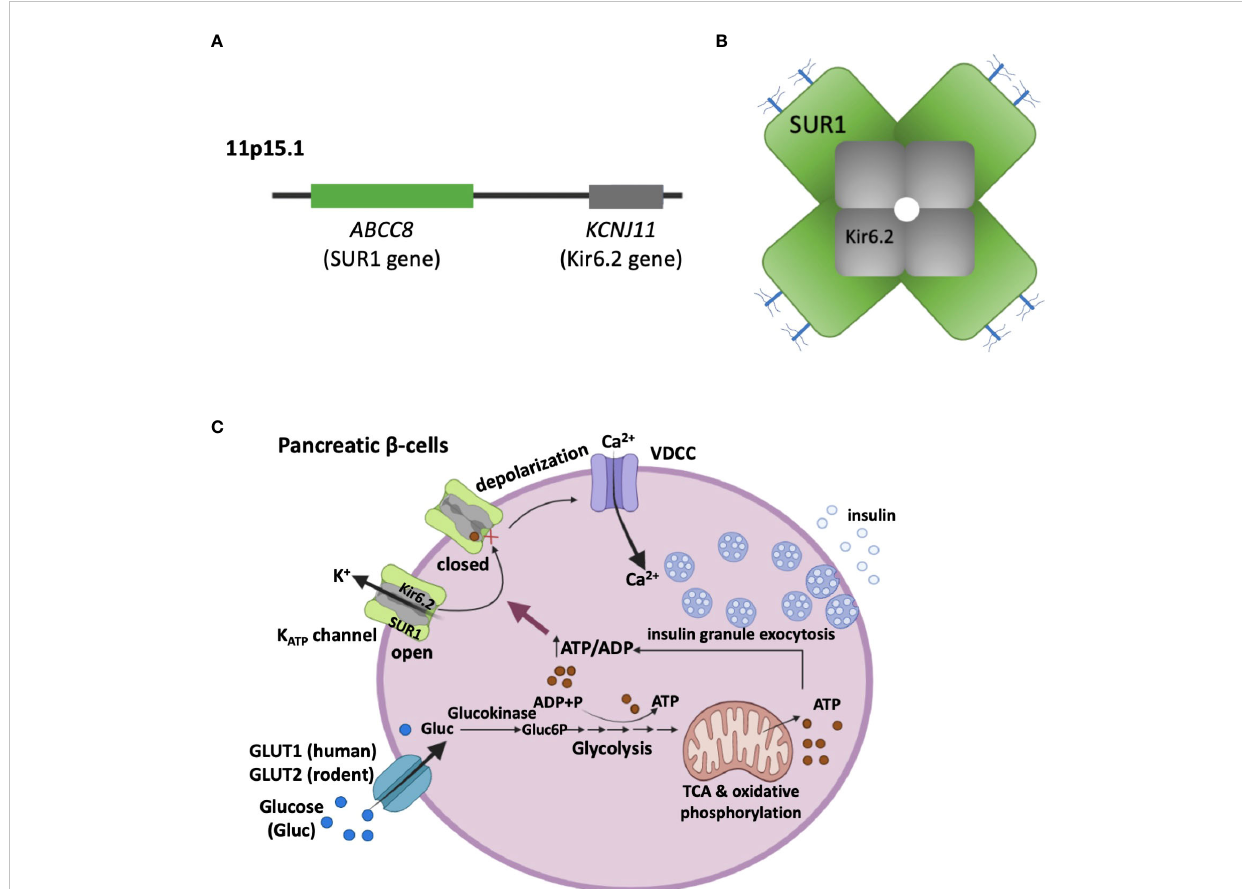
FIGURE 1 K ATP channel composition and its role in coupling glucose metabolism to insulin secretion. (A) ABCC8 and KCNJ11 encoding the two pancreatic K ATP channel subunits, SUR1 and Kir6.2 respectively, are located on the short arm of chromosome 11 (11p15.1). (B) Schematic representation of the K ATP channel complex viewed in cross section. The K + -conducting pore is formed by four Kir6.2 subunits, which are surrounded by four SUR1 regulatory subunits. The branched blue sticks represent the two N-linked glycosylation sites in each SUR1. (C) b -cell K ATP channels couple glucose metabolism to insulin secretion by regulating plasma membrane potential in response to varying blood glucose levels. With high serum blood glucose levels, glucose enters b -cells through glucose transporters (GLUT1 in human, and GLUT2 in rodents). Inside the cell, glucose is catabolized in the cytosol (Glycolysis) and the mitochondria (Tricarboxylic acid cycle, TCA), leading to an elevation of the ATP/ADP ratio. This results in closure of K ATP channels, plasma membrane depolarization, opening of voltage-dependent Ca 2+ channels (VDCC). The ensuing Ca 2+ in fl ux then triggers exocytosis of insulin secretory